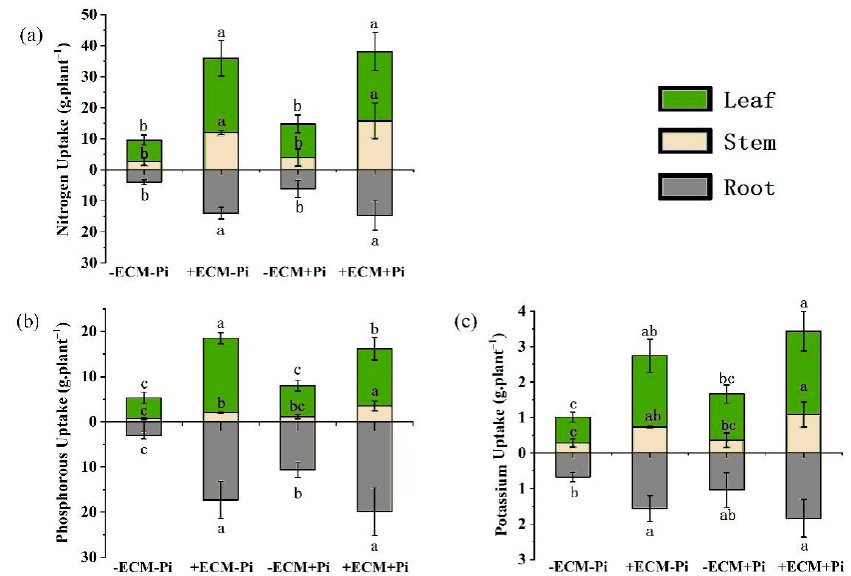
Figure 3. The effects of ECMF and Pi levels on nutrient uptake in leaves, stems, and roots of C. henryi seedlings. -ECM-Pi: uninoculated and low Pi; -ECM+Pi: uninoculated and high Pi; +ECM-Pi: inocu- lated and low Pi; +ECM+Pi: inoculated and high Pi. ( a ) The N uptake (g ‧ plant − 1 ) of each treatment; ( b ) the P uptake (g ‧ plant − 1 ) of each treatment; ( c ) the K uptake (g ‧ plant − 1 ) of each treatment. Color denotes, green (leaf), yellow (stem) and grey (root). The error bars refer to standard deviation. Different letters indicate significant differences among treatments ( p < 0.05) according to Duncan’s multiple range test.